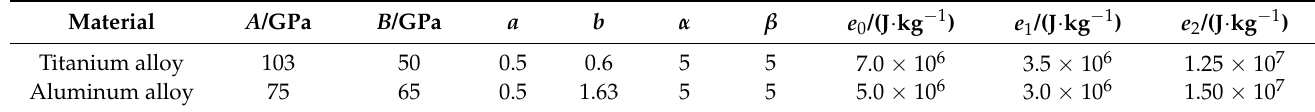
Table 1. Parameters of Tillotson state equation for titanium and aluminum.